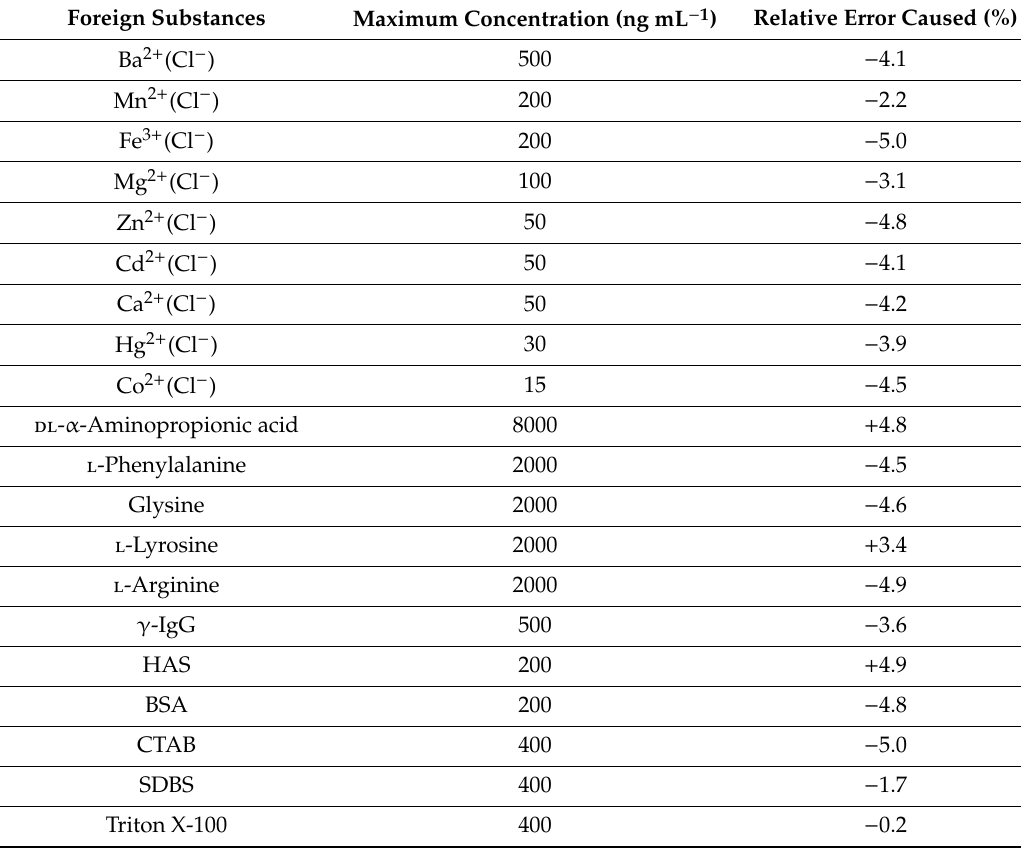
Table 1. Checked interfering elements used to evaluate the device selectivity. Adapted from ref. [55]. Foreign